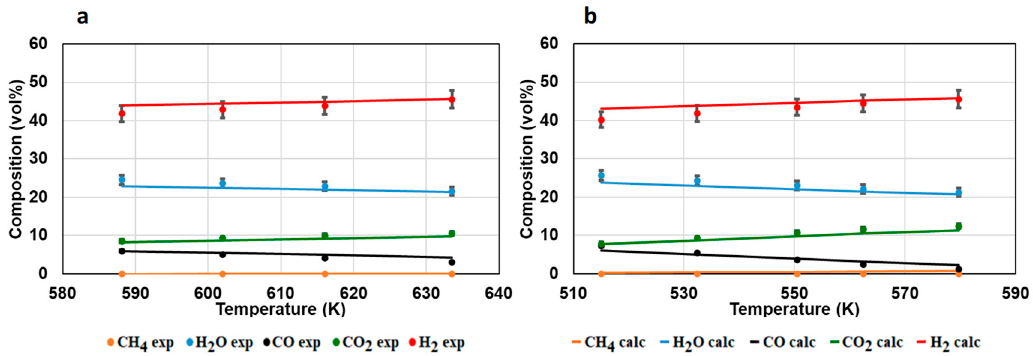
Figure 9. Comparison of the experimental results and the kinetic model results for the structured catalyst, in the condition H 2 O / CO = 24 / 7, at two di ff erent contact times, 23 ms ( a ) and 131 ms ( b catalyst, in the condition H 2 O/CO = 24/7, at two different contact times, 23 ms ( a ) and 131 ms ( b ).